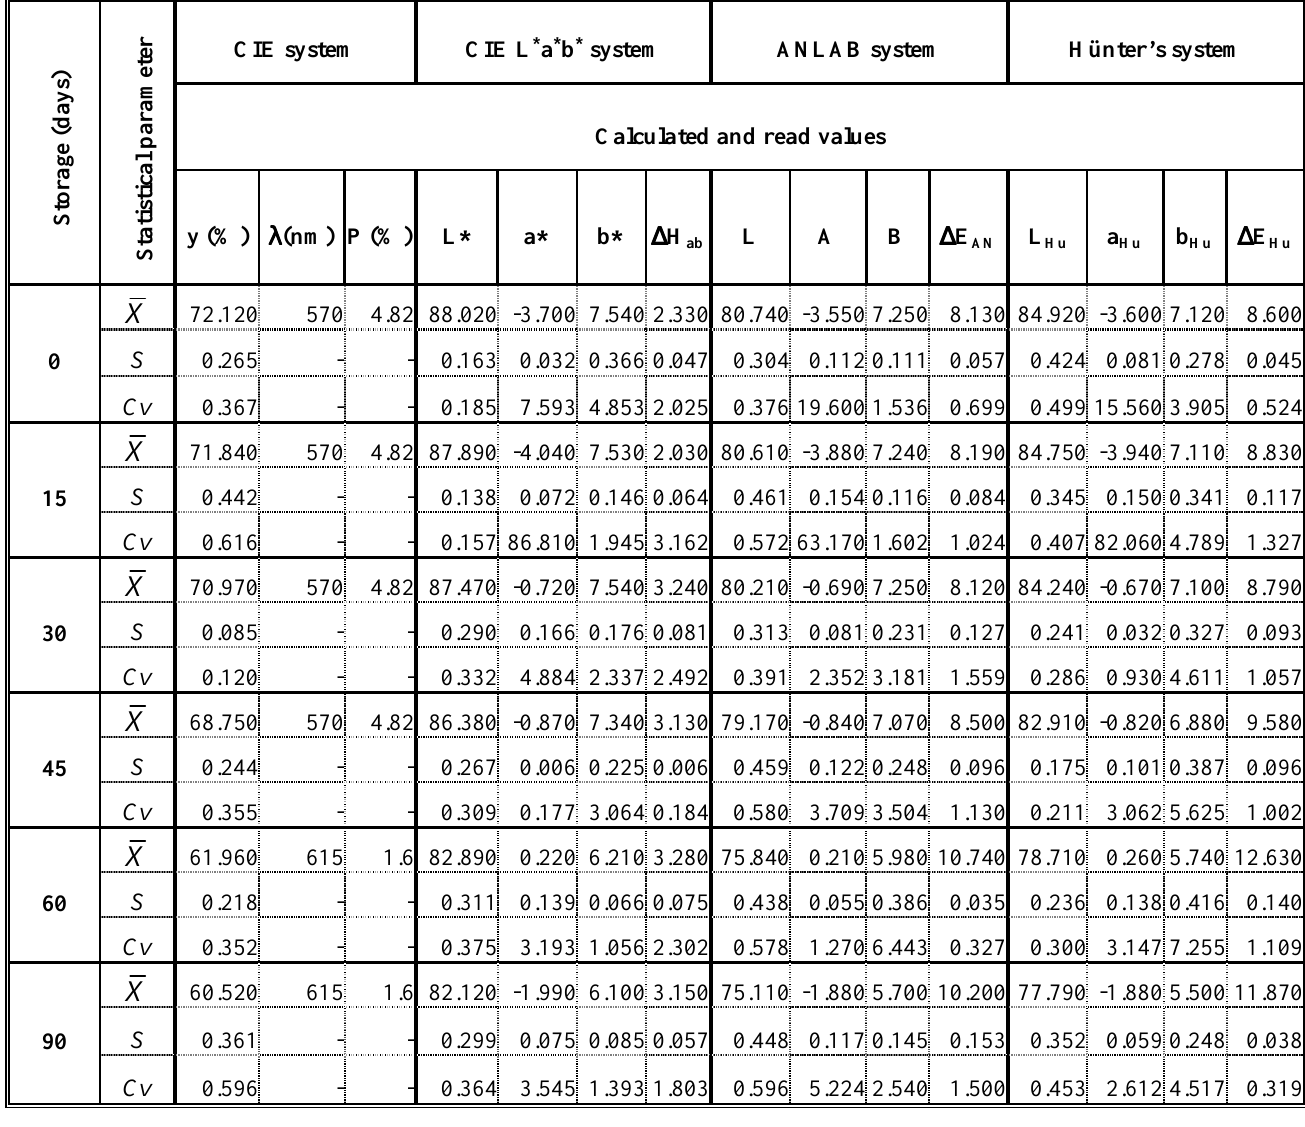
Table 2 . Results of instrumental determination of color of UHT milk with 1.6% milk fat during storage up to 90 days at ambient temperature (20